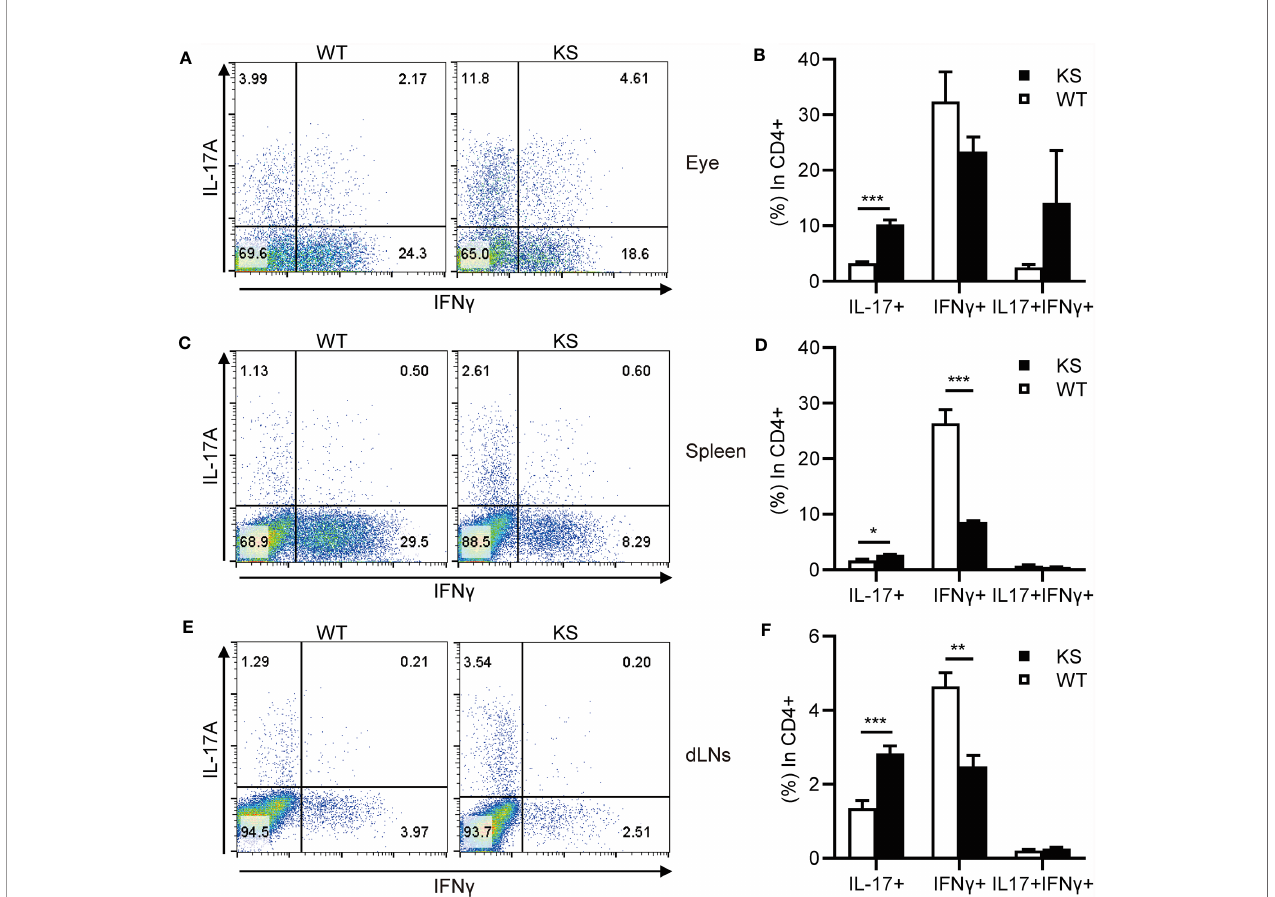
FIGURE 3 | KS mice show an increased accumulation of autoreactive effector T cells and a skewing toward Th17 in fi ltration after EAU immunization. The cells harvested from eye, spleen or dLNs of WT and KS mice 14-16 days after immunization were stimulated with PMA, ionomycin plus brefeldin for 5 h, then stained with anti-CD4 mAb and intracellular anti-IL-17A and anti-IFN- g mAbs, followed by FACS analysis. (A, C, E) FACS plot are representative of three similar independent experiments. (B, D, F) Bar diagram are shown for frequencies of IL-17A + , IFN- g + or IL-17A + IFN- g + cells in total CD4 + T cells from immunized WT and KS mice. Data are presented as mean ± SEM. *p < 0.05, **p < 0.01, ***P < 0.001. (Unpaired Student ’ s t